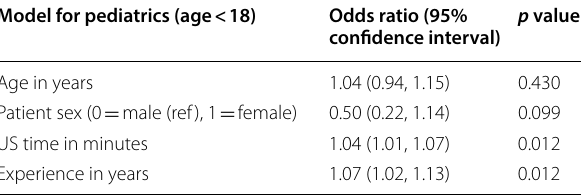
Table 2 Multivariable logistic regression model (0 seen, 1 visualized) =